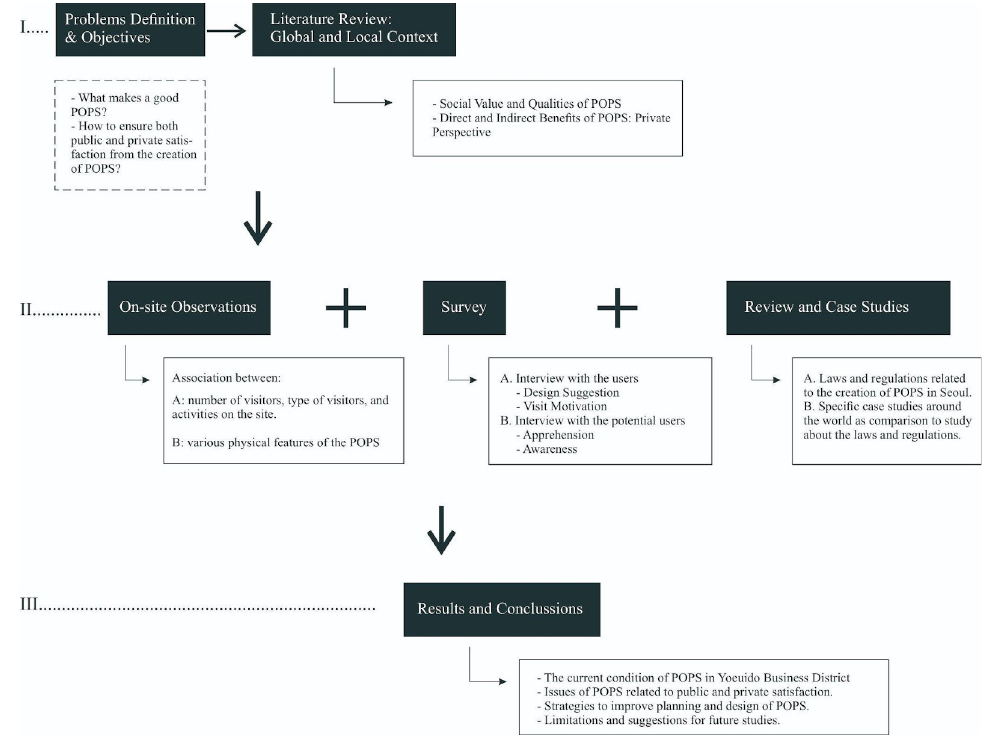
Figure 1. The research framework.